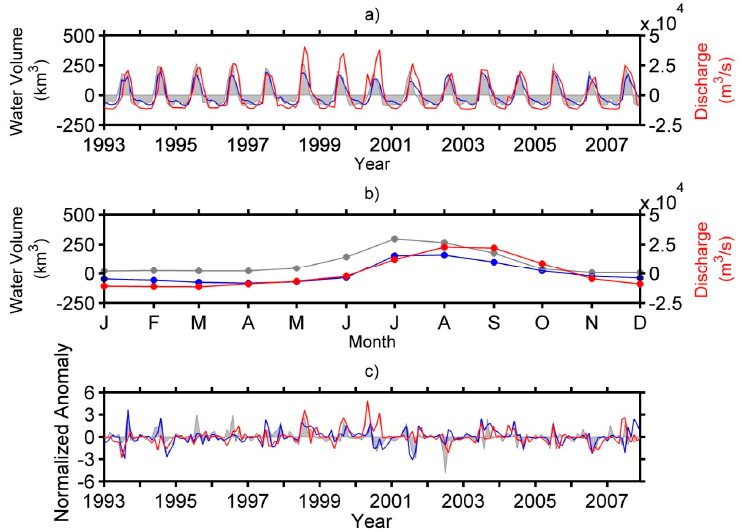
Figure 8. Surface water storage (blue) time series comparison with precipitation (gray) and discharges (red) over the Ganges catchment: ( a ) Annual variations; ( b ) Mean seasonal cycle; ( c ) Inter-annual variations.